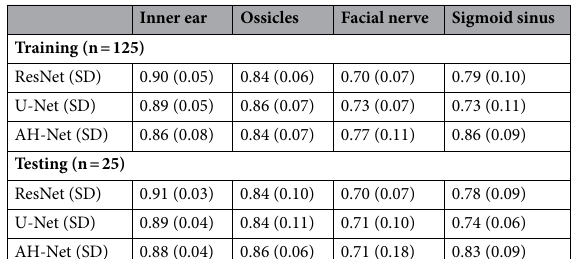
Inner ear Ossicles Facial nerve Sigmoid